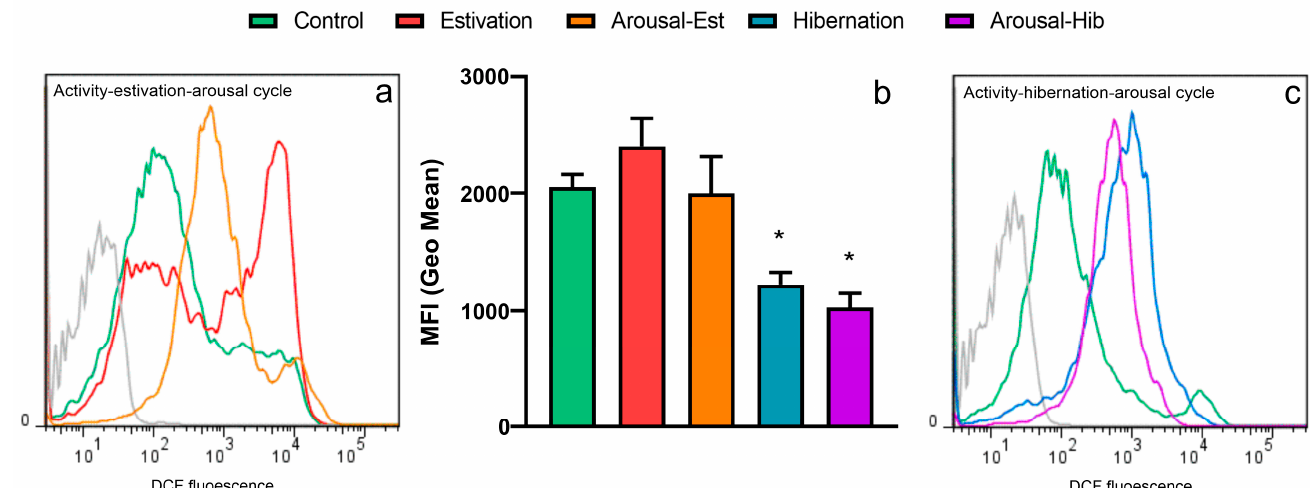
Figure 3. Production of ROS by circulating hemocytes. ( a ) Flow cytometry histograms showing distinct peaks of DCF fluorescence corresponding to different ROS levels for active, est, and arousal-est hemocytes; ( b ) changes in the mean fluorescence intensity (MFI) of DCF between groups; ( c ) histograms showing the fluorescence peaks of active, hib and arousal-hib hemocytes. Gray histograms represent autofluorescence controls. Asterisks (*) indicate significant differences with the control group ( p < 0.05, Kruskal-Wallis, Dunn’s test).